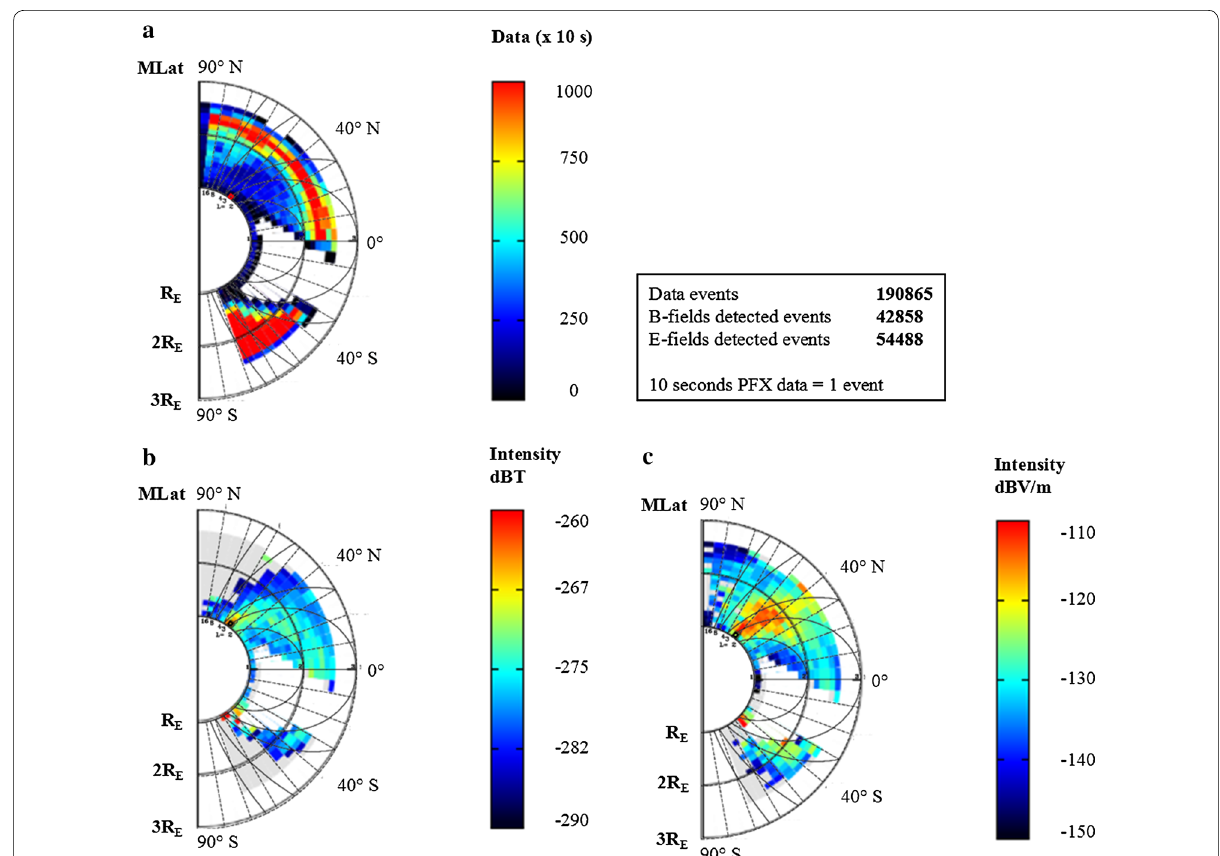
Fig. 5 a Duration of data processed in the magnetic and electric fields with longitude restricted to North Dakota station in the magnetic field and c in the electric field. The rectangle indicates the location of the North Dakota station at latitude 55.98° N and longitude 34.83°